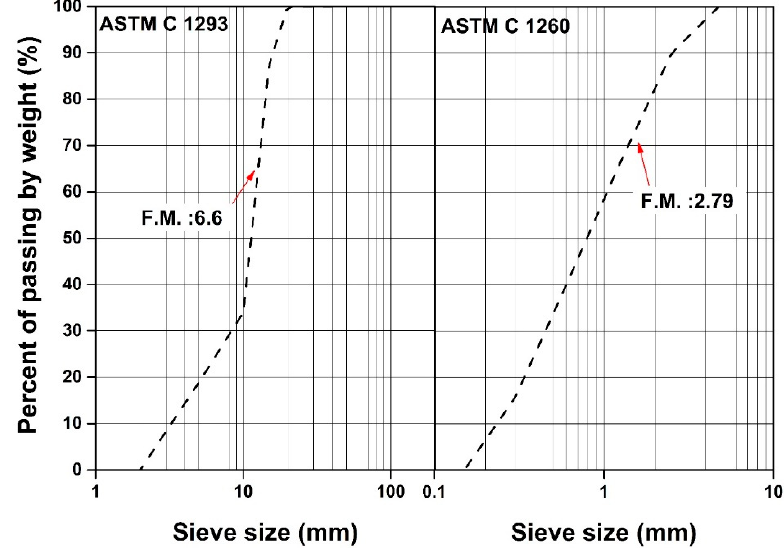
Figure 1. Grading curves of aggregate.